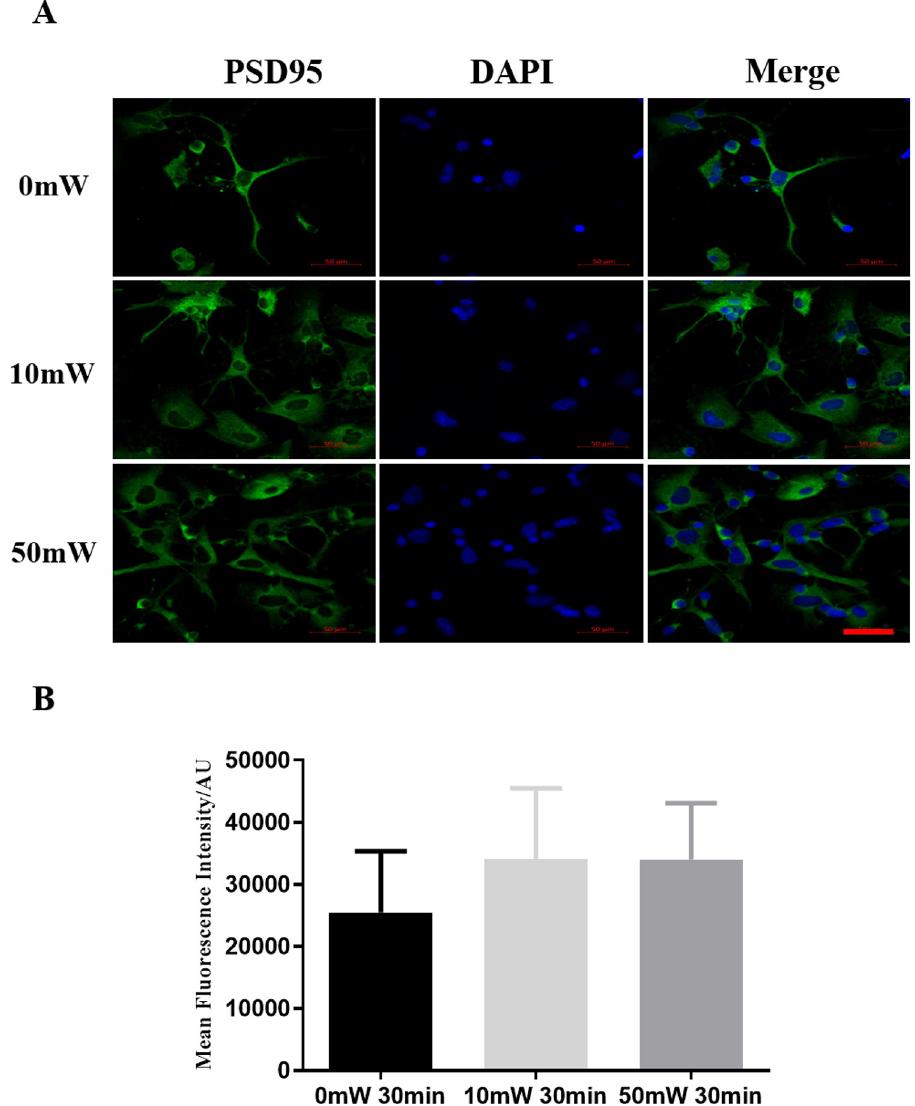
Fig 4. Expression of PSD-95 protein in neurons after exposure to terahertz radiation. Primary rat hippocampal neurons were exposed to terahertz radiation at an average power of 0, 10 mW (0.12 THz) or 50 mW (0.157 THz) for 30 min. The expression and localization of PSD-95 (green) was examined by immunofluorescence staining. Scale bar = 50 μ m. Three independent experiments were conducted. The representative images were shown in A , and the statistical analysis were shown in